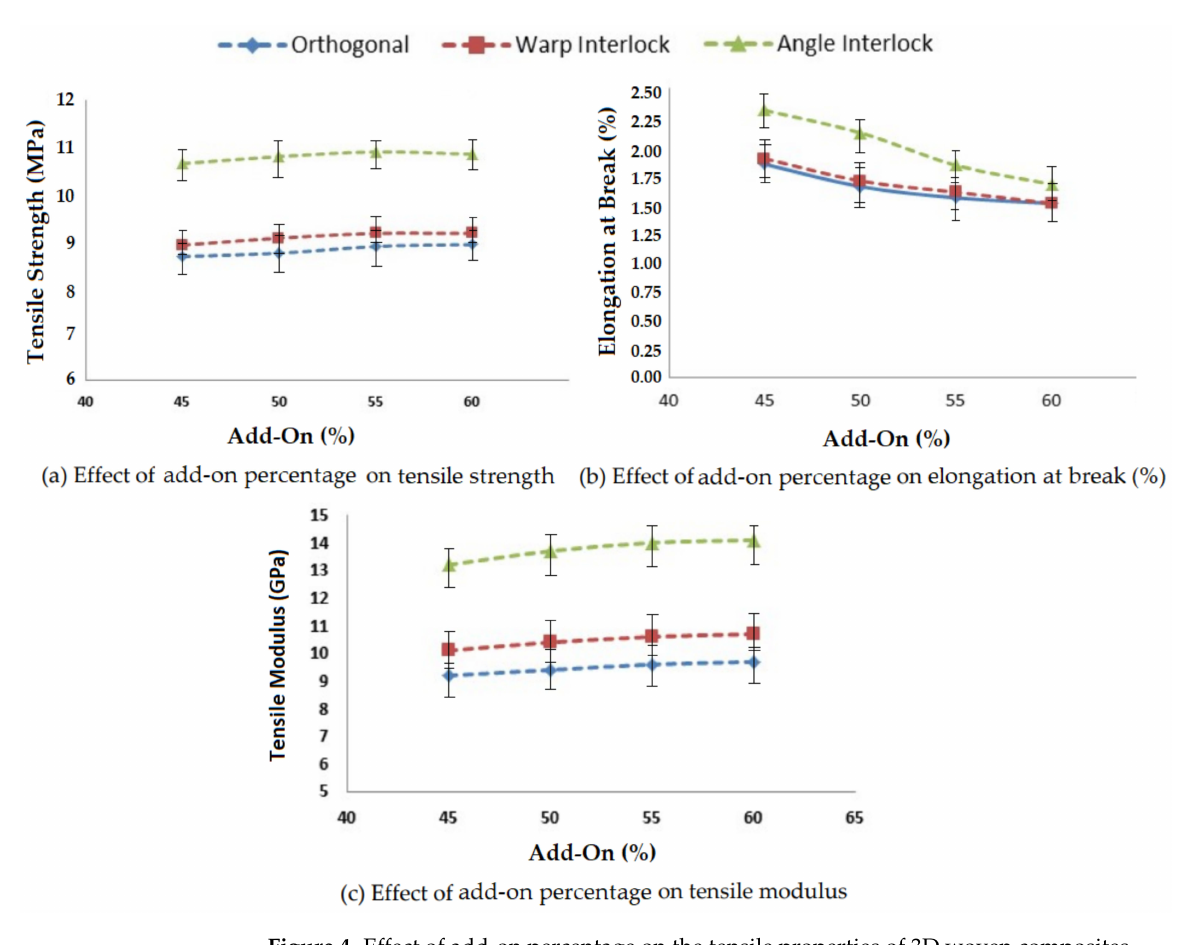
Figure 4. Effect of add-on percentage on the tensile properties of 3D woven